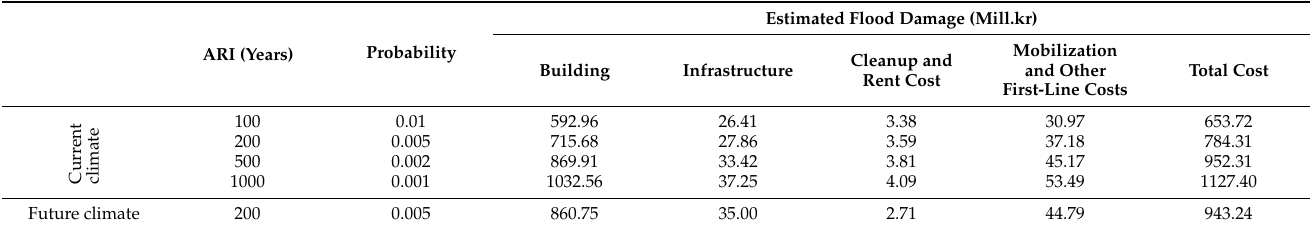
Table 6. Estimates of flood damage cost for building and infrastructure for various